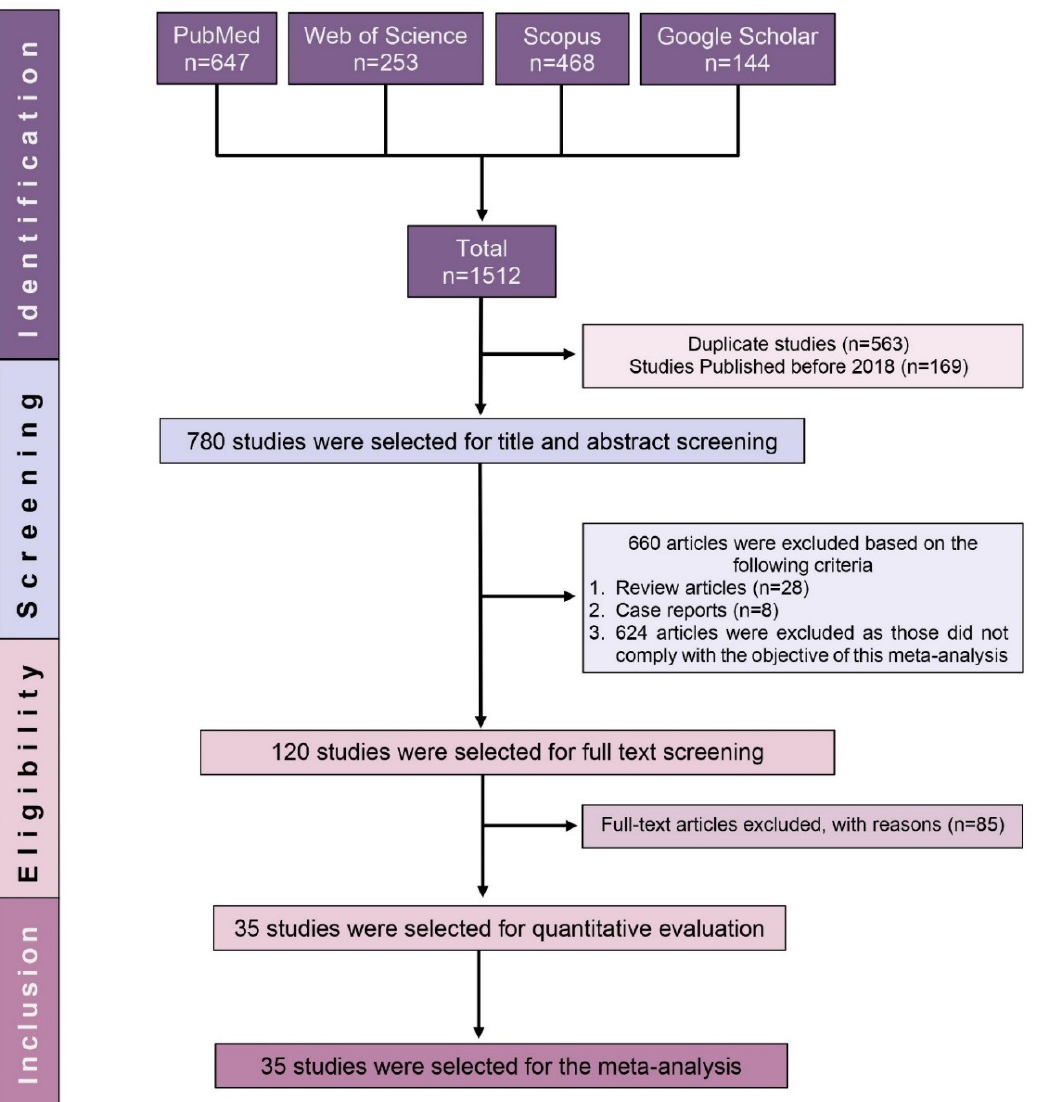
Figure 1. PRISMA flow diagram of study selection.